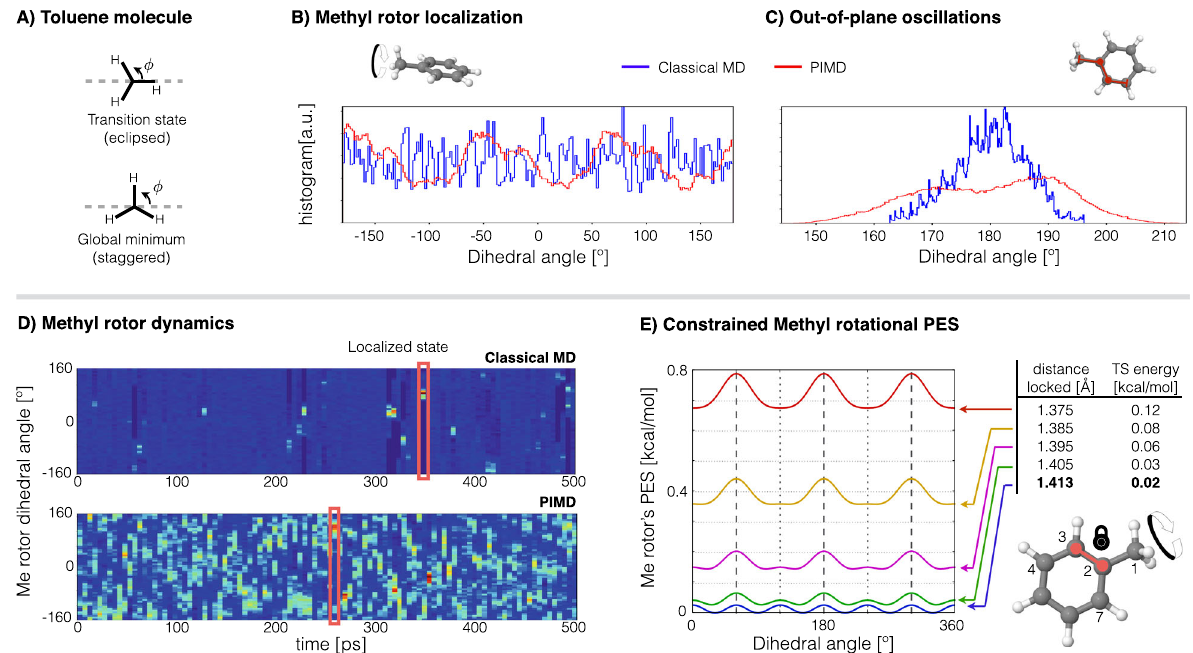
Fig. 3 Hindering of methyl rotor dynamics by nuclear delocalization in toluene molecule. A Global minima and transition state of Me rotor. Histogram of the Me rotor ’ s dihedral angle ( B ) and out-of-plane dihedral angle ( C ) computed from classical MD (blue) and PIMD (red). D Time evolution of the Me rotor for classical MD (top) and PIMD (bottom) simulations. The red rectangles indicate some of the localized states in the dynamics. The size of the bins are 5 ps × 6 ∘ . The simulations were done at room temperature at the sGDML@CCSD(T) level of theory. E Methyl rotor ’ s PES and its transition state (TS) energy for different fi xed values of the C 2 − C 3 distance (marked in red). In a localized state, there is a quasi-linear correlation between C 2 − C 3 and C 2 − (cid:4) (cid:3) d C 7 distances, d C C 2 (cid:3) C 3 (See Supplementary Note 7 for further 2 (cid:3) C 7